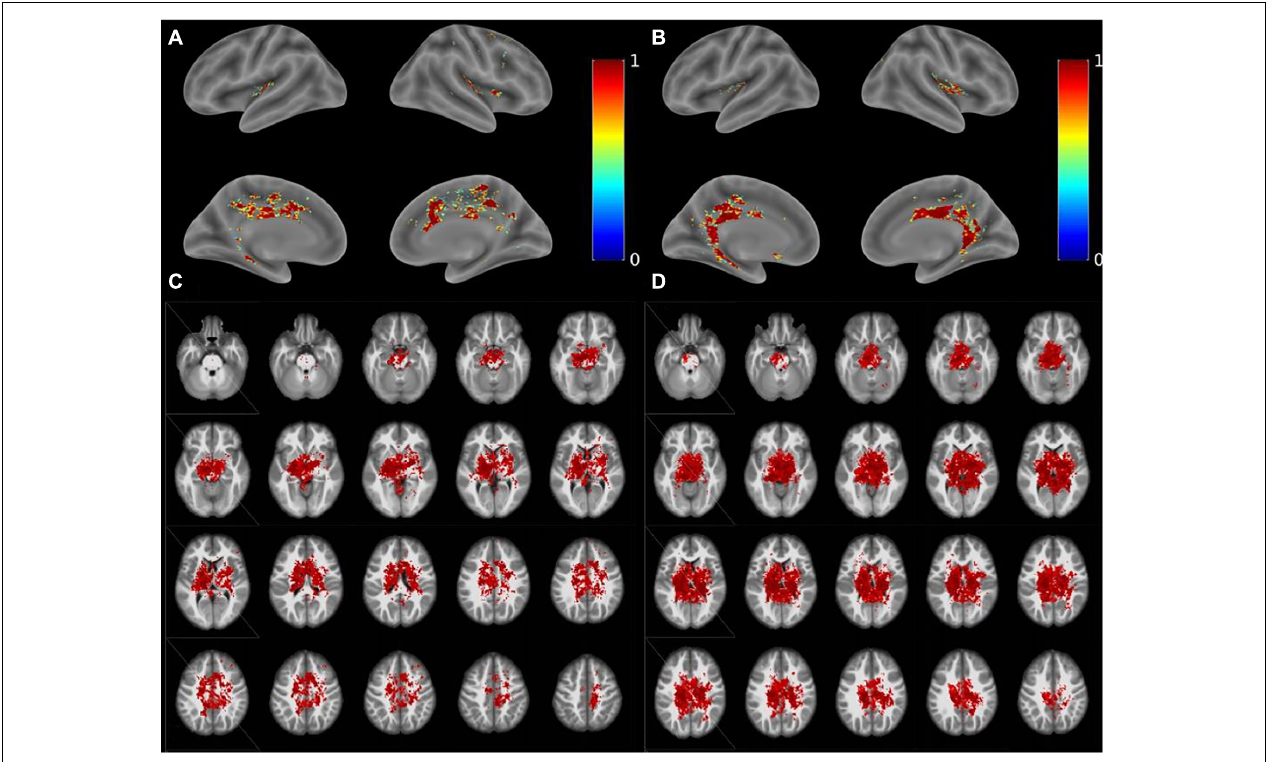
FIGURE 4 | Results of diffusion tractography. (A , C) Diffusion tractography results of the MCI group. (B,D) Diffusion tractography results of the NC